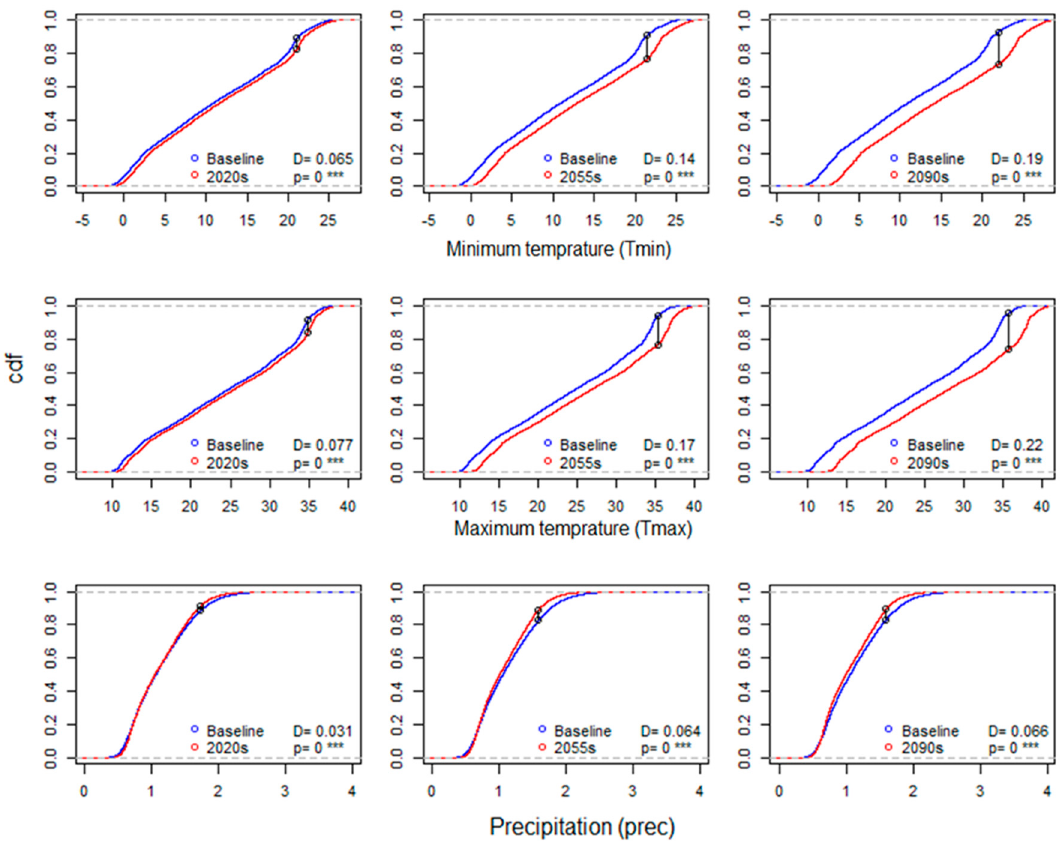
Figure 9. Kolmogorov–Smirnov (K ‐ S) statistical test results of cumulative probability functions (CDFs) of daily minimum and maximum temperature, and precipitation for future periods compared with the baseline. Calculated D ‐ values were compared with the critical D ‐ value (D c ) of 0.012 at α = 0.01 and n = 20,075.